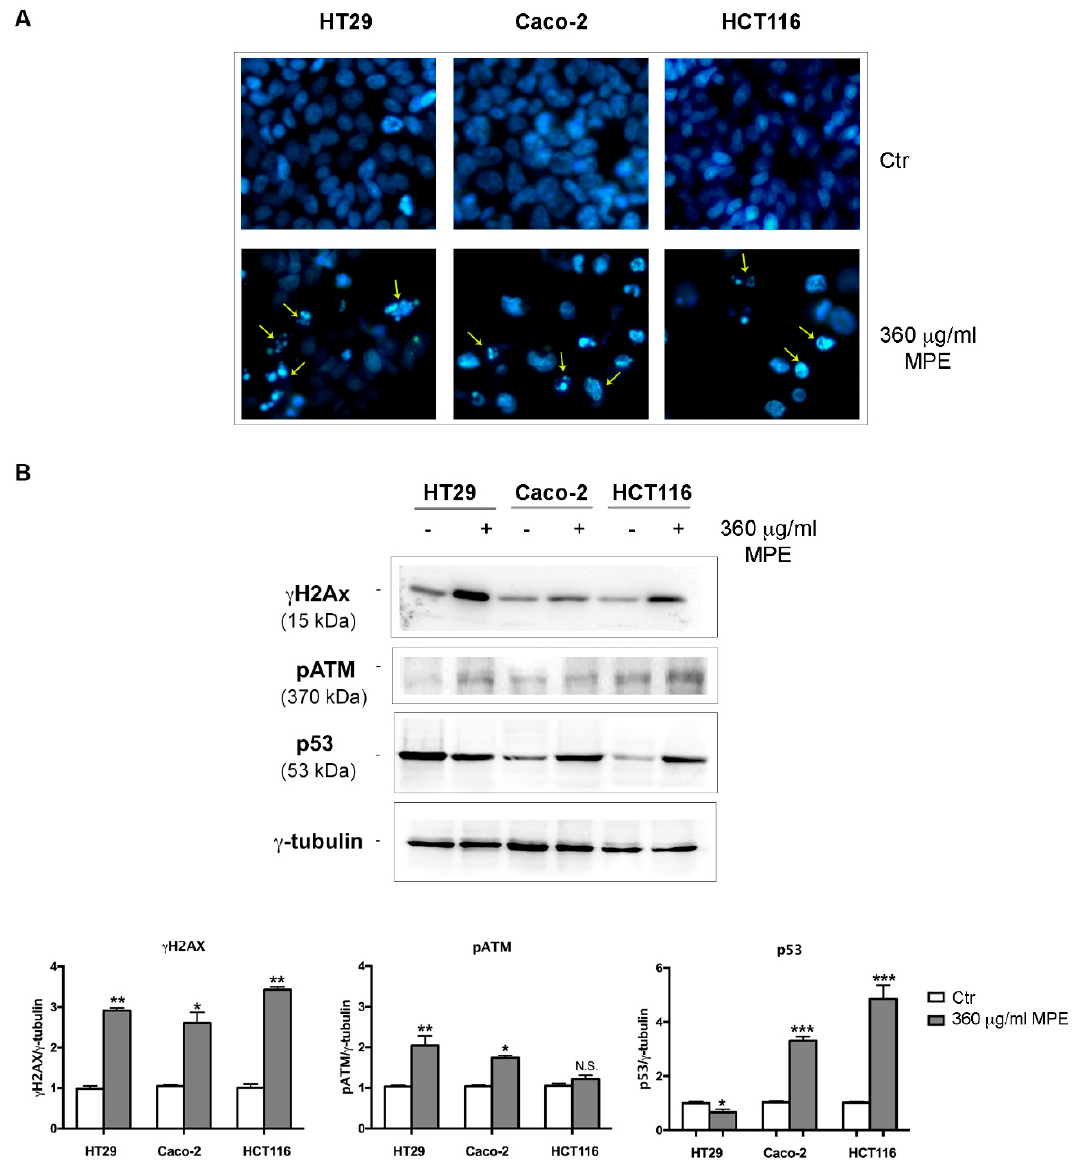
Figure 8. MPE effects on DNA damage markers. ( A ) The effect of MPE on DNA was evaluated using Hoechst 33342 staining in colon cancer cells incubated with MPE for 48 h. The pictures (original magnification 400 × ) were acquired using a 4 (cid:48) ,6-diamidino-2-phenylindole dihydrochloride (DAPI) filter with a Leica fluorescent inverted microscope using Leica Q Fluoro software. Yellow arrows indicate condensed or fragmented chromatin. ( B ) MPE provoked the phosphorylation of both H2AX ( γ H2AX) and ATM (pATM) and p53 upregulation. All colon cancer cells (HT29, Caco-2 and HCT116) were treated for 48 h in the presence of 360 µ g / mL MPE. Then, cell lysates were analyzed using western blotting with specific antibodies directed against the proteins of interest, as reported in Materials and Methods. The correct protein loading was ascertained by immunoblotting for γ -tubulin. Representative blots of three independent experiments and densitometry analysis histogram normalized to γ -tubulin are reported in the bottom panel. (*) p < 0.05, (**) p < 0.01 and (***) p < 0.001 compared to the untreated sample. N.S., not